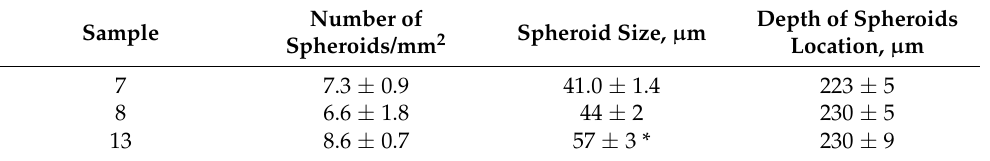
Table 6. Characteristics of spheroids on the tested cryogel samples (mean ±